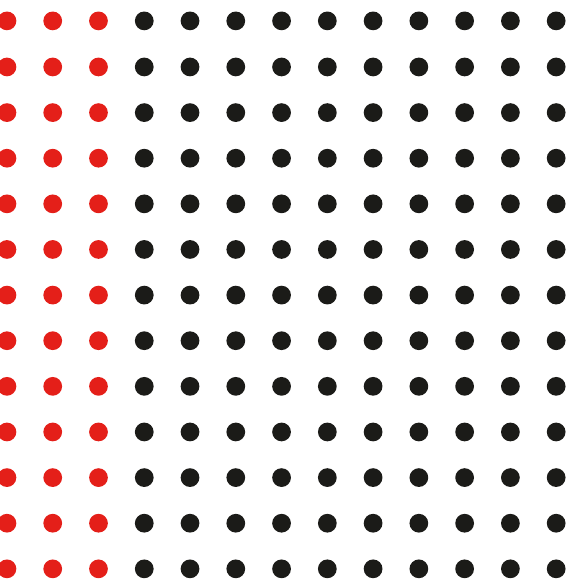
Figure 13: Schematic diagram of uplifted nodes under standard case: 52 nodes uplifted and uplift area ratio is